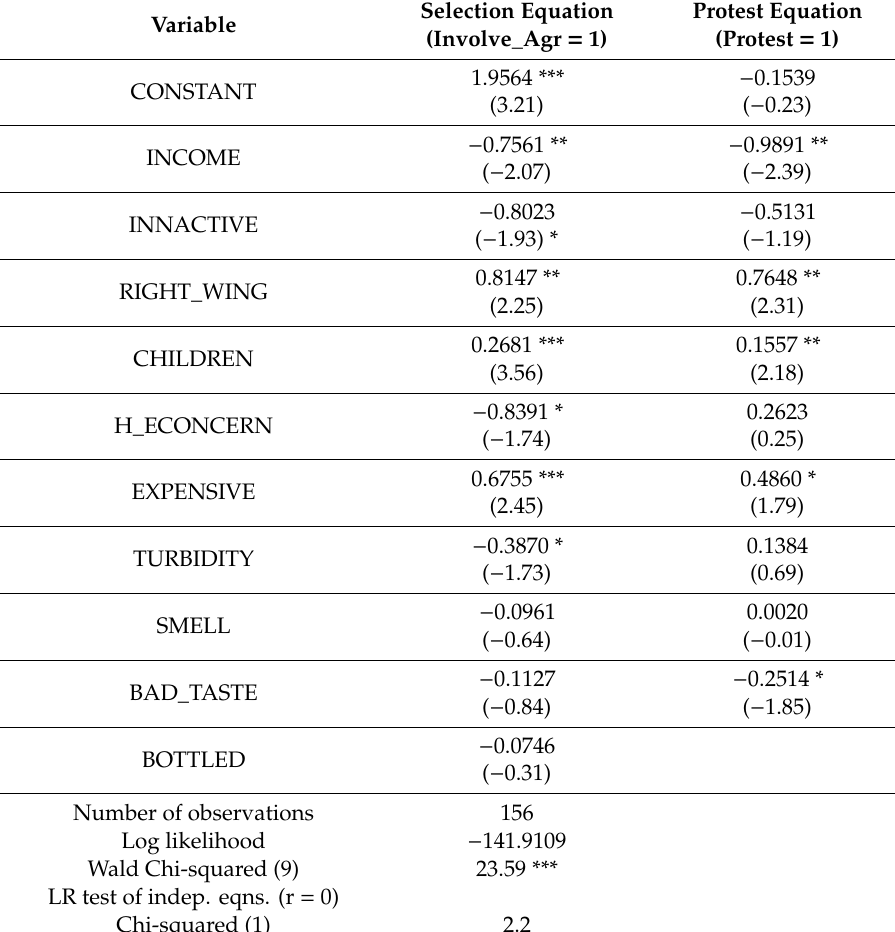
Table 5. Probit selection model and protesting